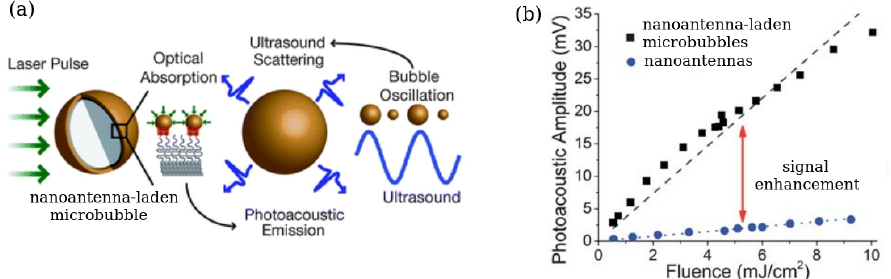
Figure 16. ( a ) Illustration of the operating principles of a nanoantenna-laden microbubble contrast agent. Superior photoacoustic properties are achieved owing to high optical absorption of nanoan- tennas embedded into the microbubble shell. These ultrasmall nanoantennas do not affect acoustic properties of a microbubble allowing it to serve as an efficient contrast agent for ultrasound waves. ( b ) Amplitude of the photoacoustic response obtained at various fluences of a laser light for the same nanoantenna-laden microbubble contrast agents and free-standing nanoantennas. The vertical double arrow indicates the enhancement of a photoacoustic signal due to the integration of nanoan- tennas with a microbubble. Reproduced from [195] with permission of Royal Society of